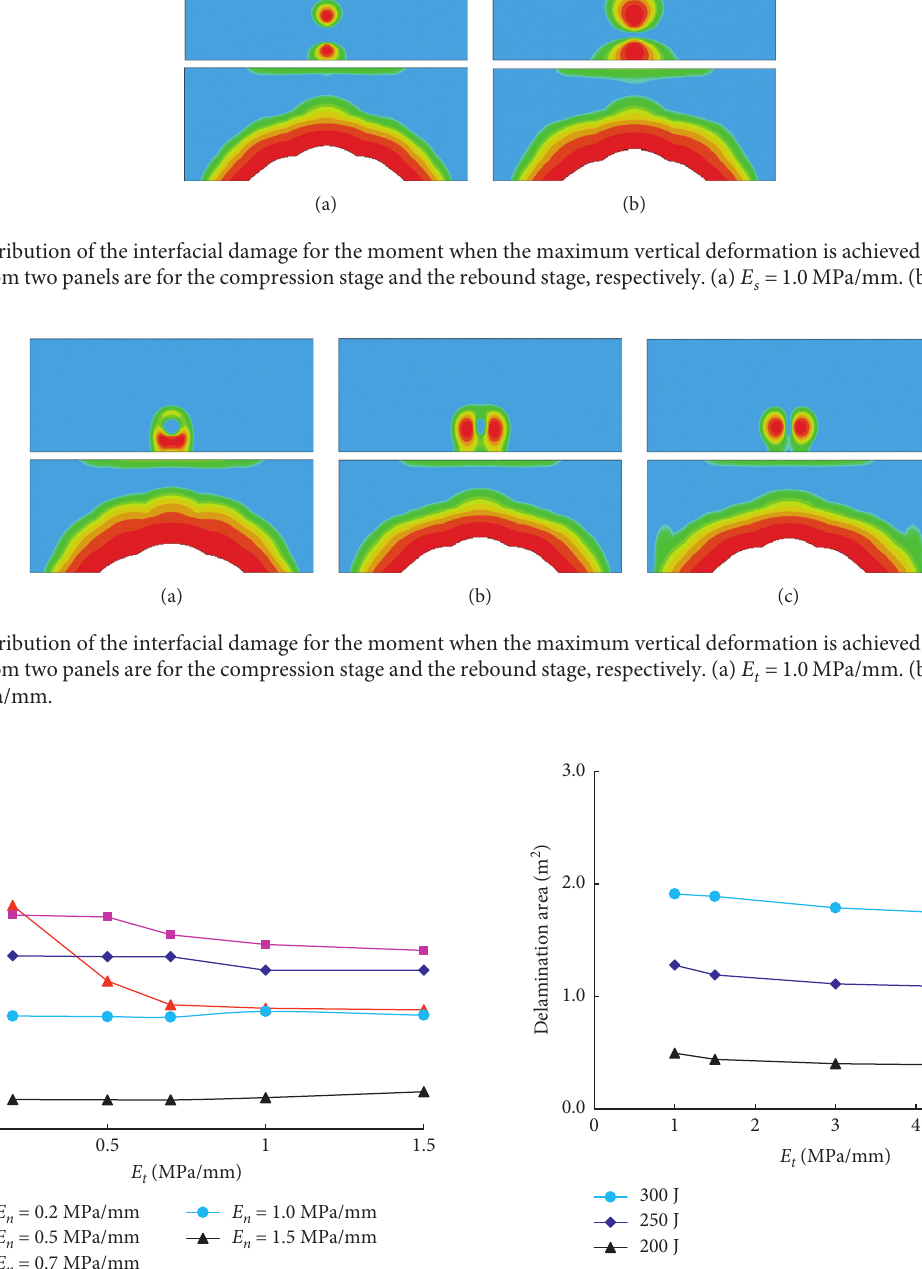
Figure 22: The delamination area versus E